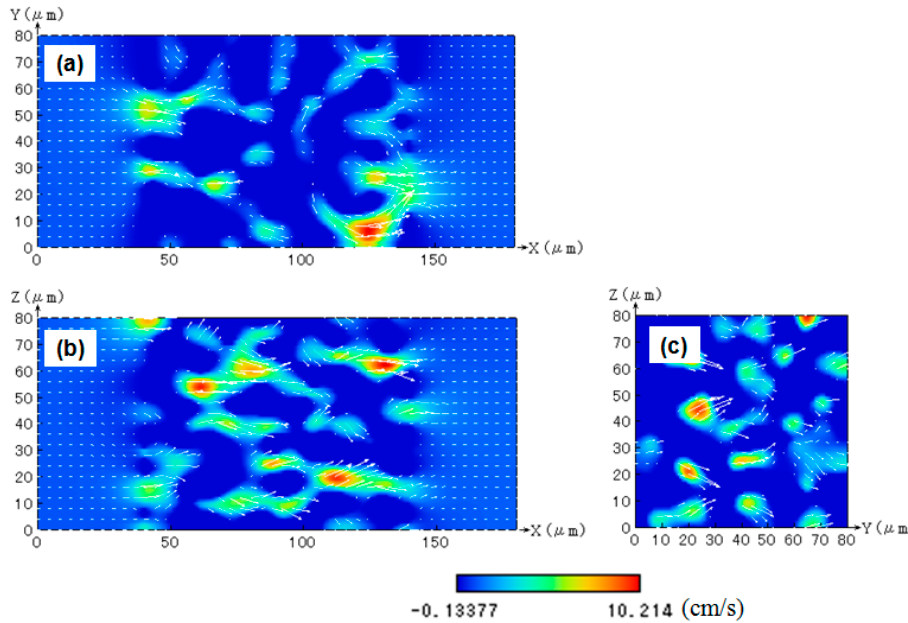
Figure 5. Distribution of velocity in ( a ) x-y plane, ( b ) x-z plane, ( c ) y-z plane.